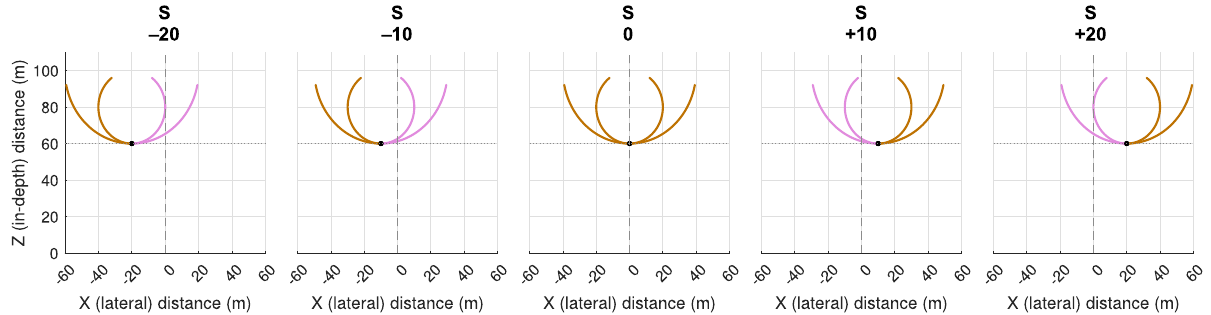
Figure 2. Initial conditions and target trajectories. The participant’s position at the onset of an experimental trial corresponded to the X–Z coordinate system’s (0,0) origin. At that moment in time, a target (represented by a black dot) appeared at a lateral position S of − 20, − 10, 0, + 10 or + 20 m, at a constant in-depth distance of 60 m. From each initial target position, targets could move along two different circular trajectories (20-m and 40-m radii), either leftward or rightward. The resulting 20 experimental target trajectories were subsequently mirror-collapsed, recoding target motion direction to inward or outward. On inward trajectories (pink) the target initially moved toward the X = 0 axis corresponding to the participant’s initial movement direction, while on outward trajectories (brown) the target initially moved away from this axis. Note that for S = 0 all target trajectories were (by definition) outward.